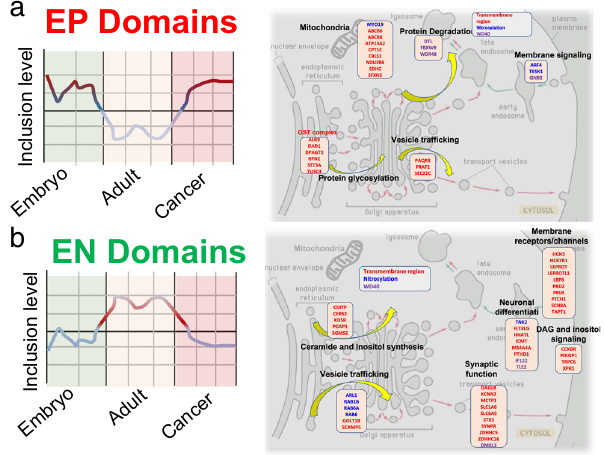
Fig. 7 | Coordinated splicing in brain development and cancer. This schematic shows the proposed role of coordinately spliced TRD, ND, and WD40 domain amongEPandENeventsinmediatingtheN-glycosylationandretrogradetransport functions. a Leftpanel ,inclusionlevelofEPdomainsindifferentdevelopmentaland pathological stages. Right panel , the host genes of EP events are enriched for oli- gosaccharyltransferase (OST) complex, vesicle traf fi cking, and mitochondria (transmembrane-region domain), protein degradation (WD40 domain), and membrane signaling (nitrosylation domain). These processes suggest active pro- tein synthesis, processing including N-glycosylation, and energy metabolism dur- ingneuralcelldevelopment. b Leftpanel ,inclusionlevelofENdomainsindifferent developmentalandpathologicalstages. Rightpanel ,thehostgenesofENeventsare enriched for vesicle traf fi cking (nitrosylation domain) and neuronal function, includingceramide/inositolsynthesis,synapticfunction,andmembranereceptors/ channels/signaling (transmembrane-region domains). Most of the genes have function required for mature neural cells (e.g., neural transmission and synaptic